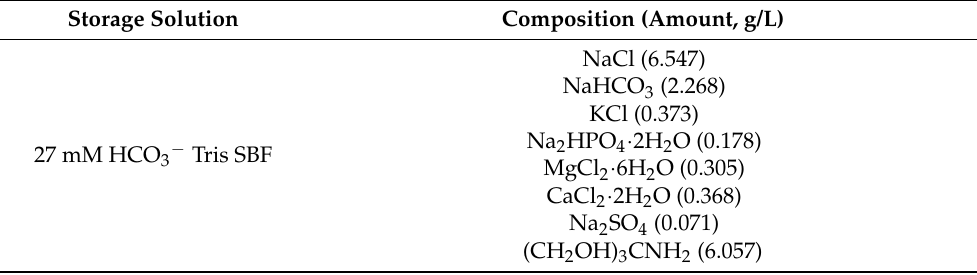
Table 2. The composition of 27 mM HCO 3 − Tris simulated body fluid